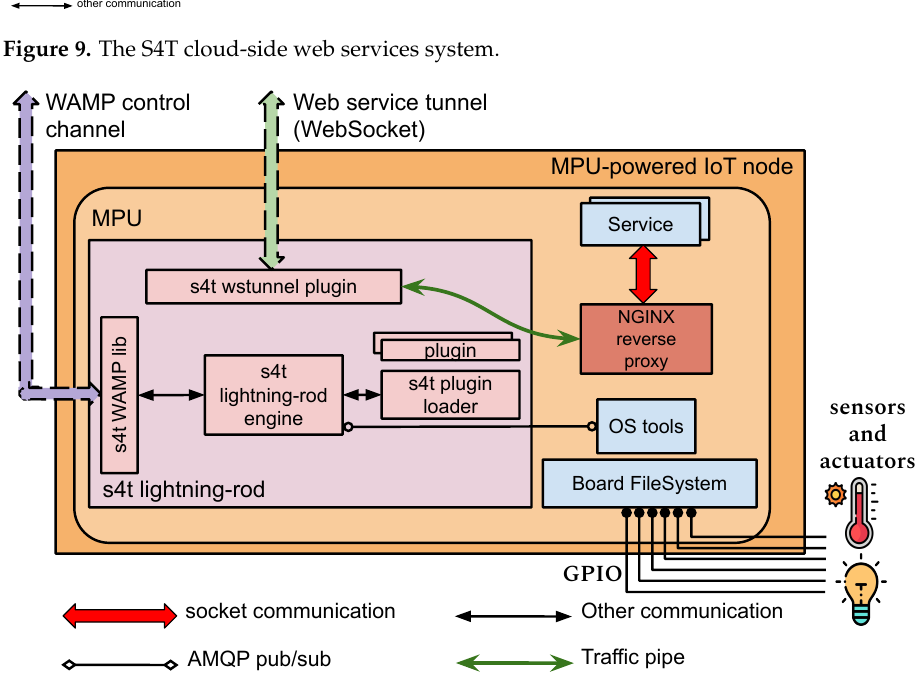
Figure 10. The device-side S4T web services